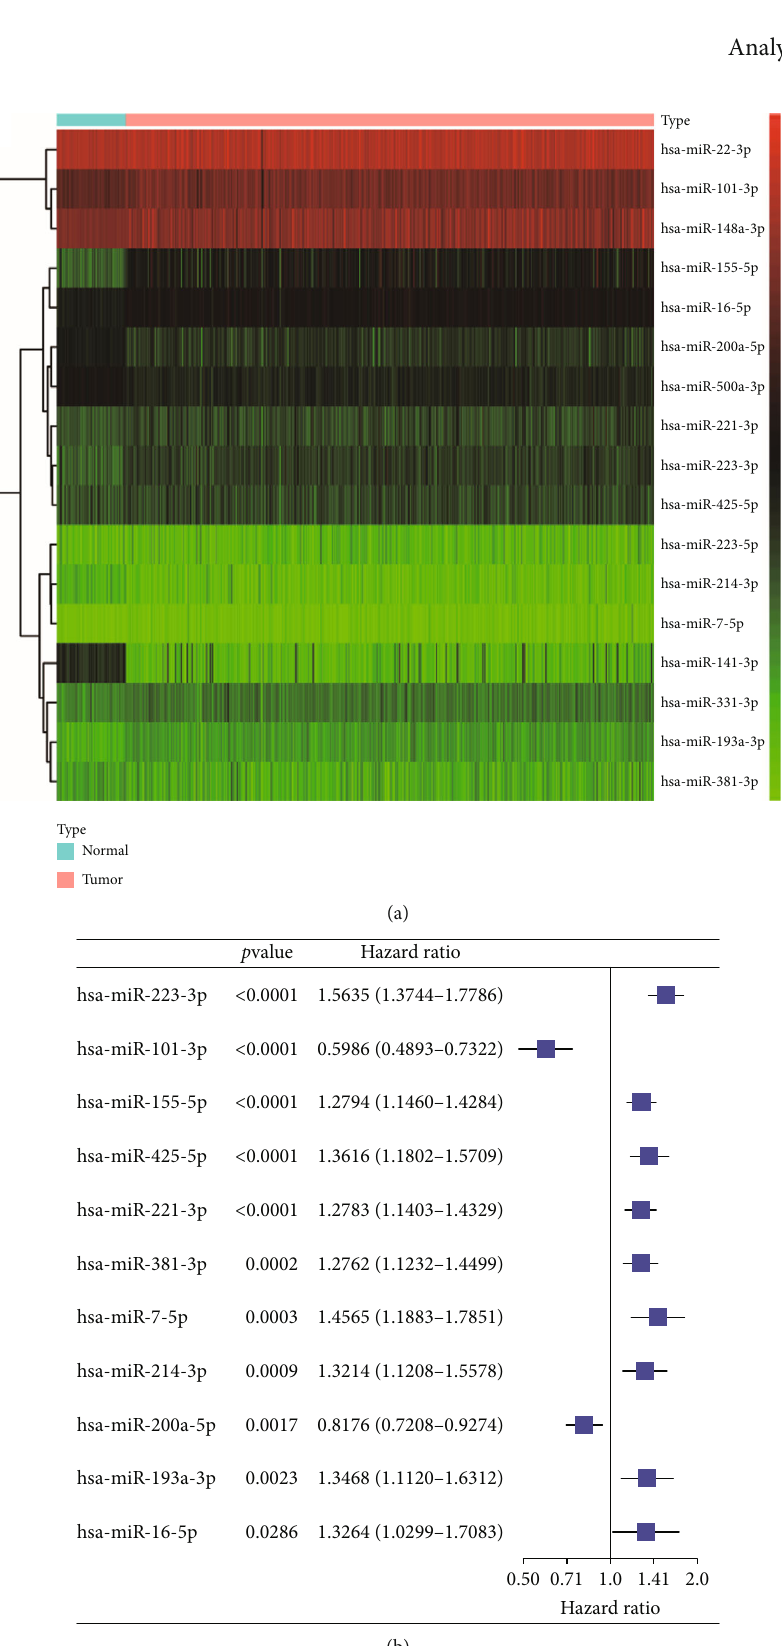
Figure 1: Identi fi cation of overall survival- (OS-) related di ff erentially expressed necroptosis-related miRNAs (NRMs). (a) Heat map showing expression levels of di ff erentially expressed NRMs. Green: low expression level; red: high expression level. (b) Forest plot of univariate Cox proportional hazard regression analysis revealed 11 OS-related di ff erentially expressed necroptosis-related